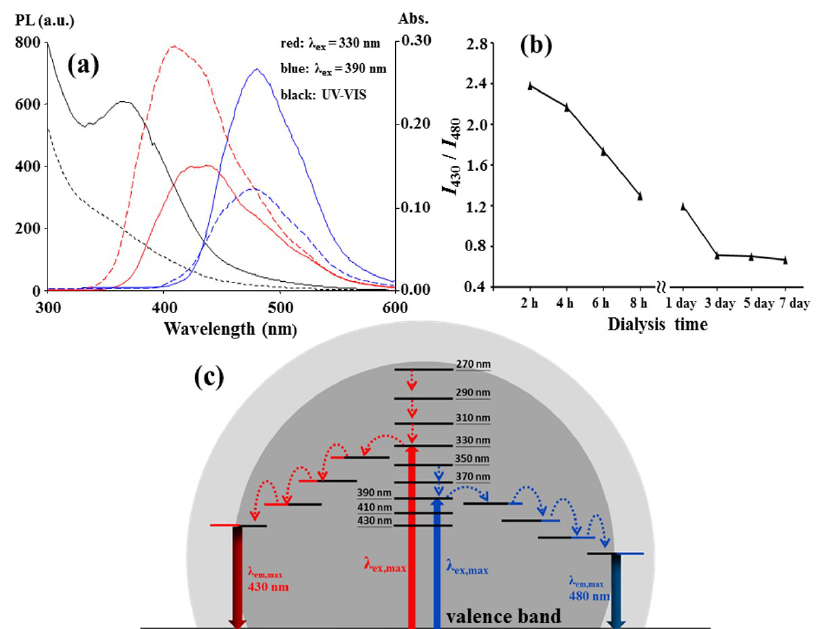
Figure 3. ( a ) Fluorescence and UV-Vis absorption spectra of the C-dots prepared in the conditions of Figure 1a before (solid lines) and after (dashed lines) dialysis in H 2 O by a 500–1000 Da cut-off membrane for two hours; ( b ) The plot of the PL intensity ratios of 430 nm PL intensity to 480 nm PL intensity with the dialysis duration; ( c ) The proposed PL mechanism.